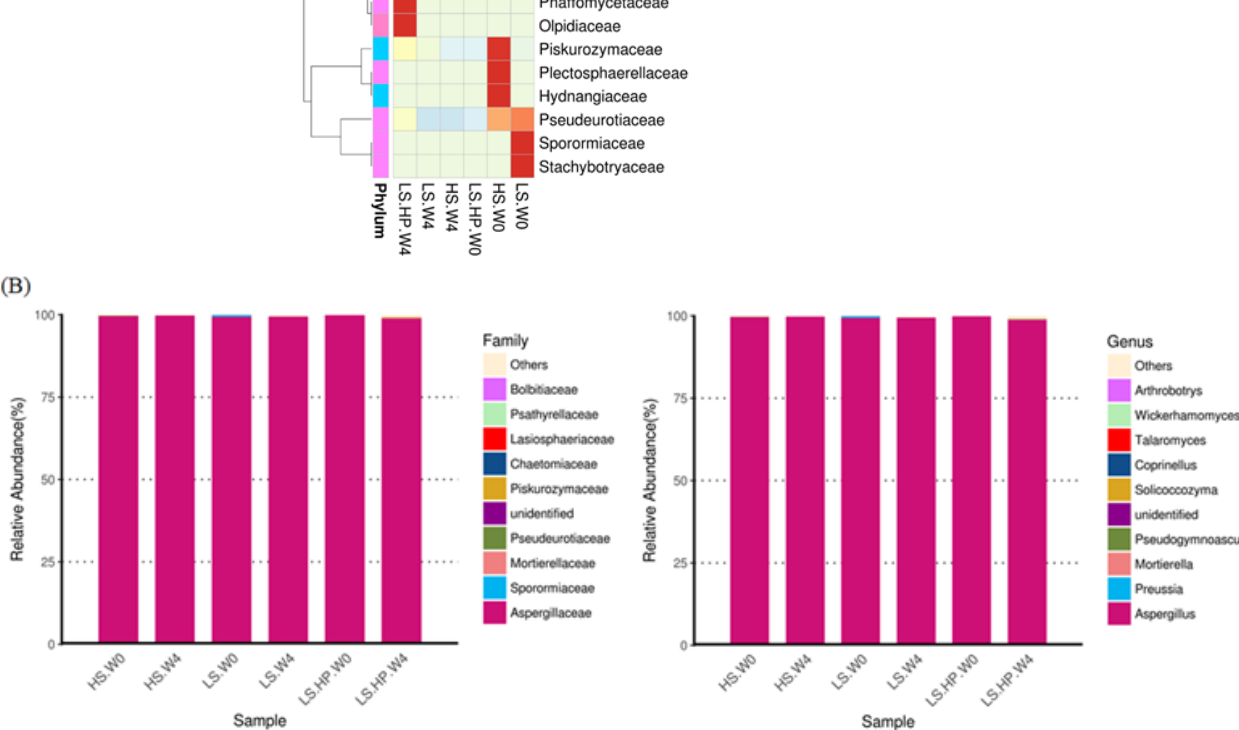
Figure 6. ( A ) The heat map obtained from analysis of fungal microbiota in high-salt (HS), low-salt (LS), and low-salt high-pressure (LS-HP) soy sauce during fermentation. ( B ) The relative abundance (%) obtained from analysis of fungal OTUs in high-salt (HS), low-salt (LS), and low-salt high-pressure (LS-HP) fermentation soy sauce.